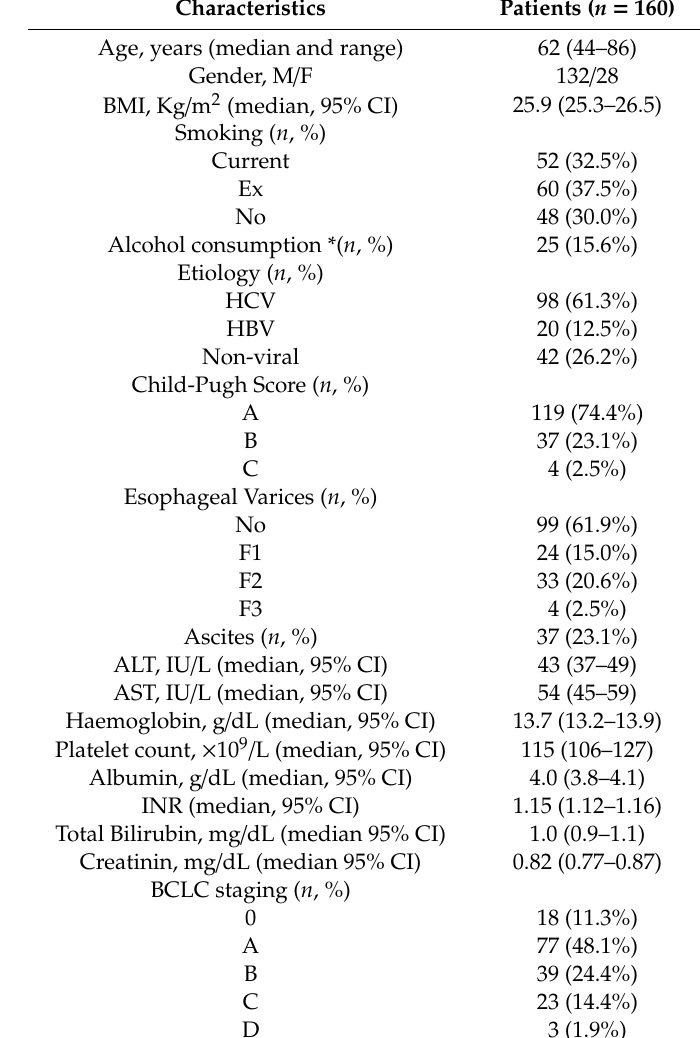
Table 1. Characteristics of the 160 patients with hepatocellular carcinoma